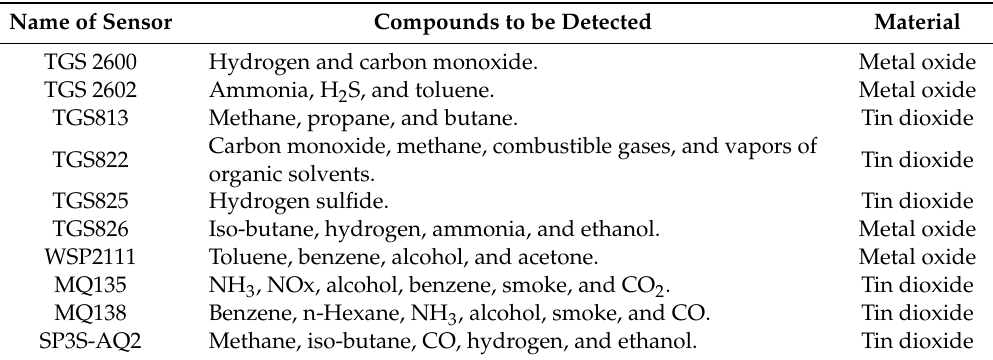
Table 1. Sensors used for the developed electronic nose (E-nose).